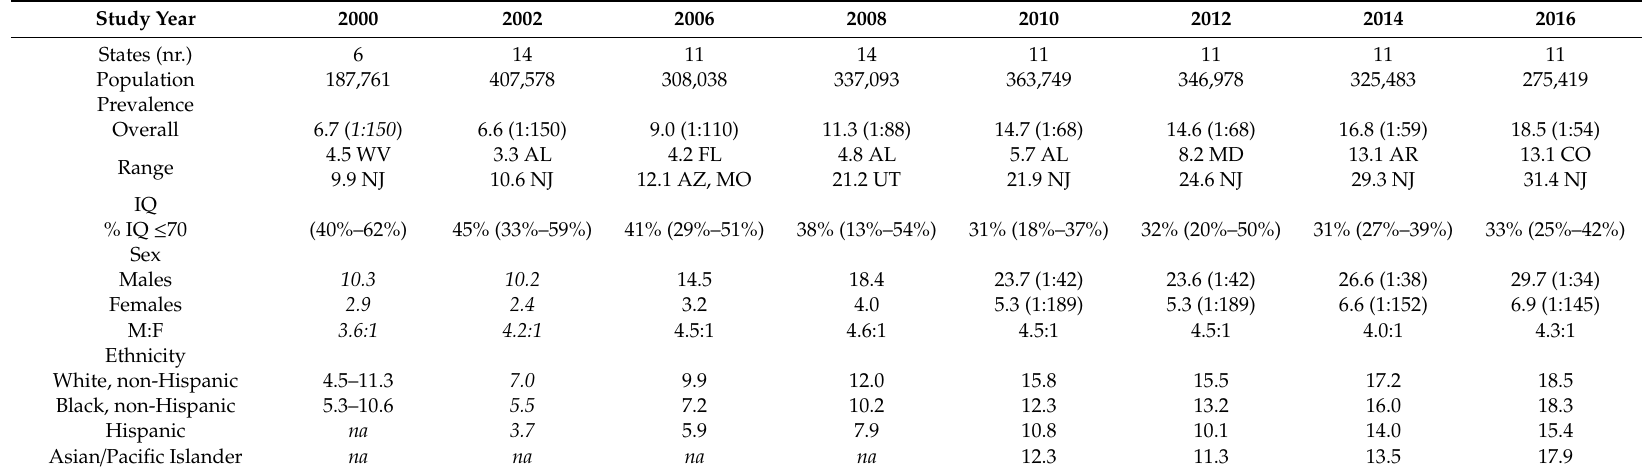
Table 5. CDC-ADDM Network ASD prevalence estimates per 1000 children aged 8 years, in the overall group and in sex and ethnicity subgroups, from 2000 to 2016 in USA [12,41,50–55].